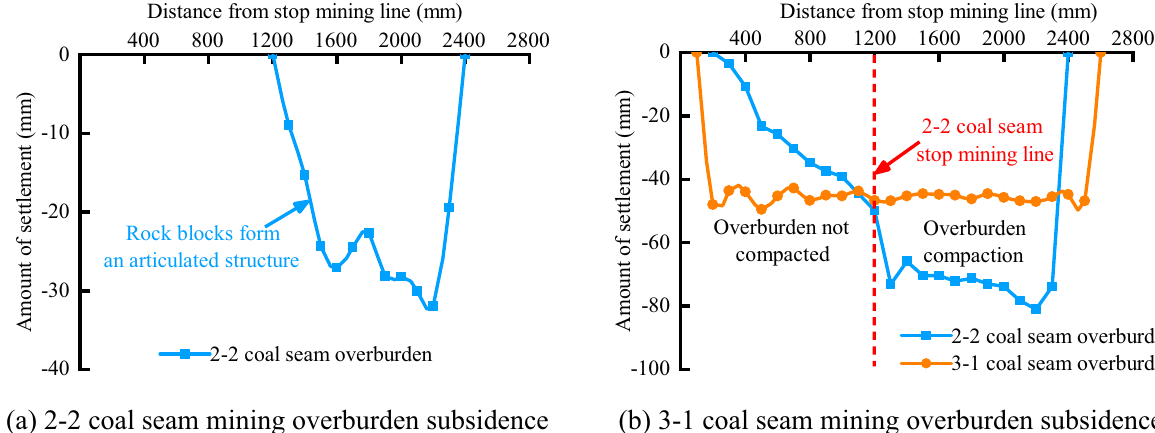
Figure 5. Settlement of overburden rock near the goaf area for close coal seam